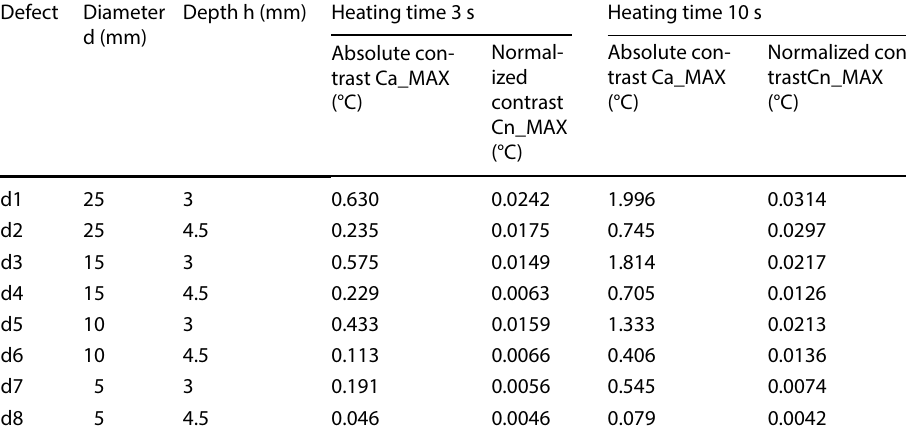
Table 5 Absolute and normalized contrast for the traditional